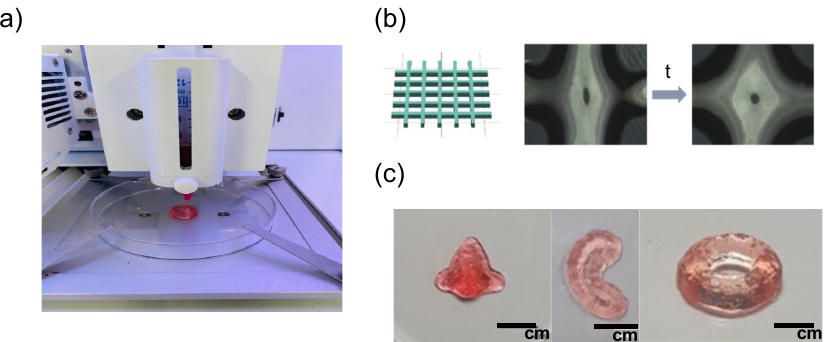
Figure 5. ( a ) Three-dimensional printing of self-healing OHA/GC/ADH/ALG hydrogel encapsulating ATDC5 cells. ( b ) Microscopic images of 3D-printed filaments of OHA/GC/ADH/ALG self-healing hydrogel and ( c ) 3D-printed constructs of various shapes.